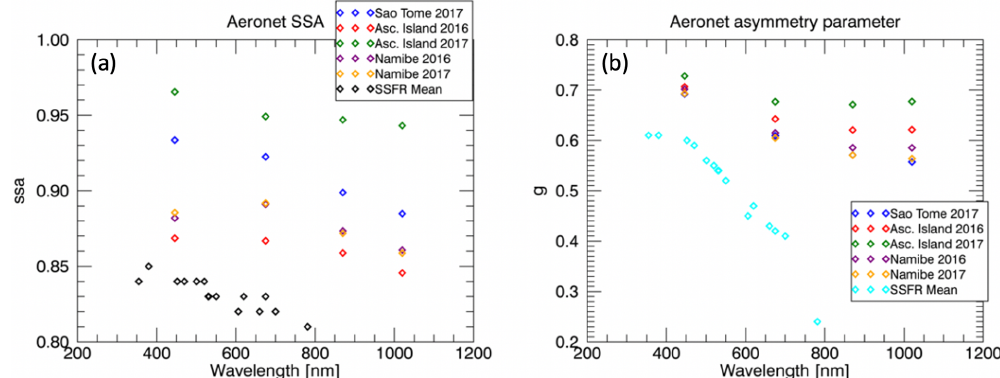
Figure B2. Retrieved values of (a) SSA and (b) g compared AERONET-measured values at nearby land